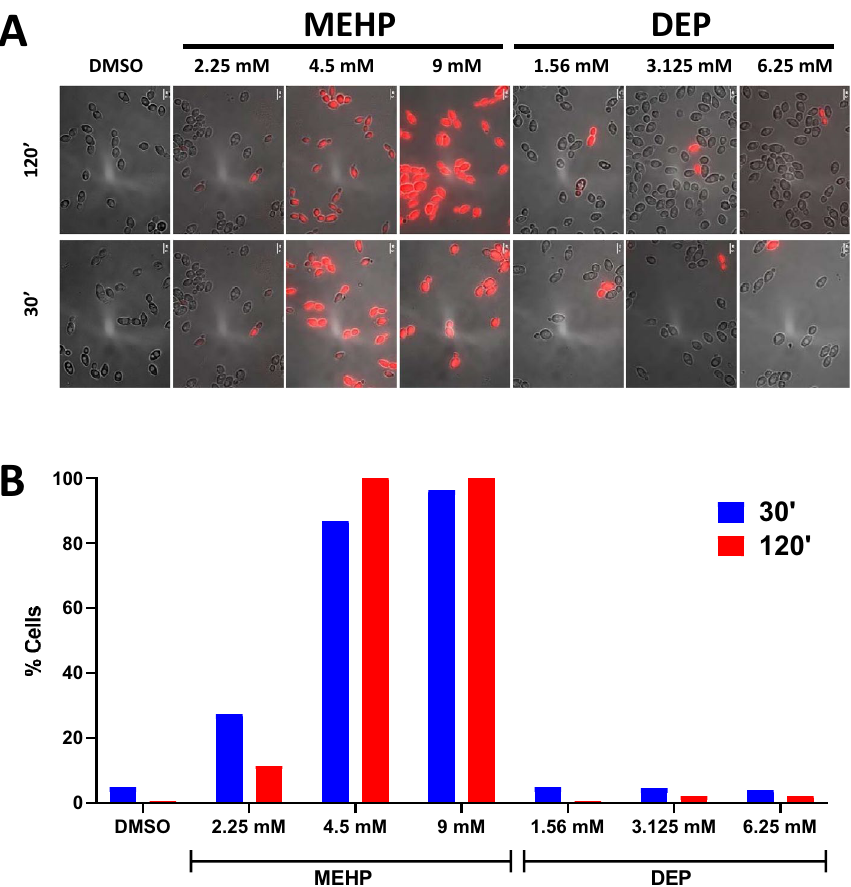
Figure 2. DEP does not affect plasma membrane integrity of yeast cells. ( A ) Representative composite bright field and fluorescence microscopy images of propidium iodide uptake in yeast after 30 min and 2 h exposure to DMSO, MEHP (2.25, 4.5, 9 mM) and DEP (1.56, 3.125, 6.25 mM). Scale bar = 5 µm. ( B ) Percentage of DMSO, MEHP (2.25, 4.5, 9 mM) and DEP (1.56, 3.125, 6.25 mM) treated cells containing propidium iodide (N ≥ 100